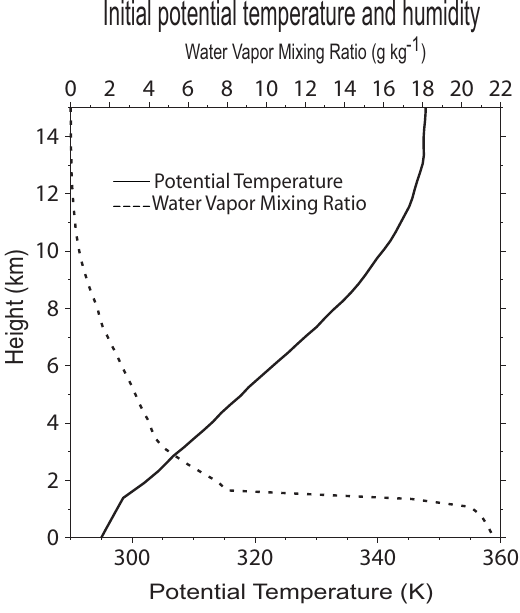
Fig. 1. Vertical profiles of initial potential temperature and water vapor mixing